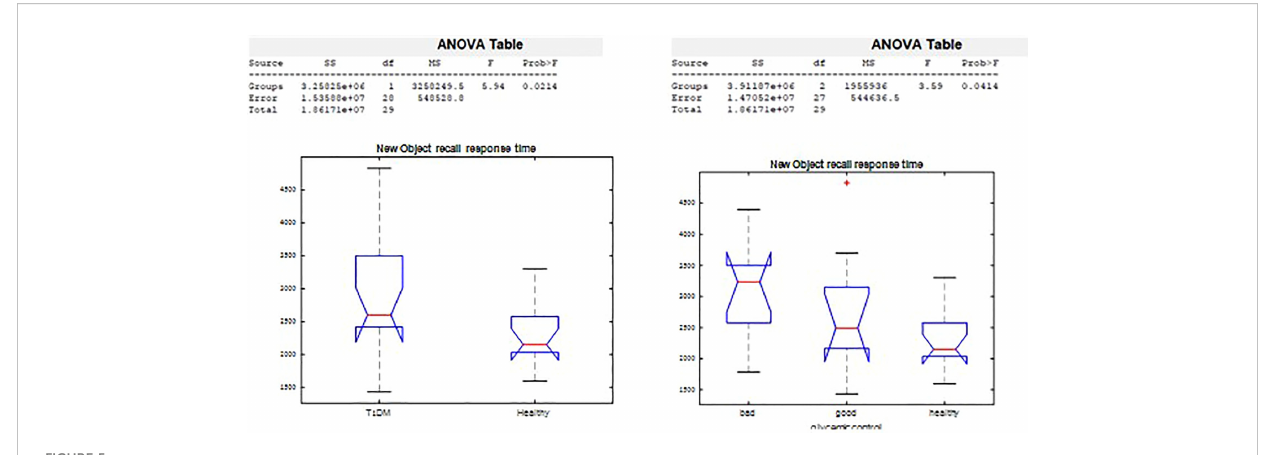
FIGURE 5 New Object Recall signi fi cant